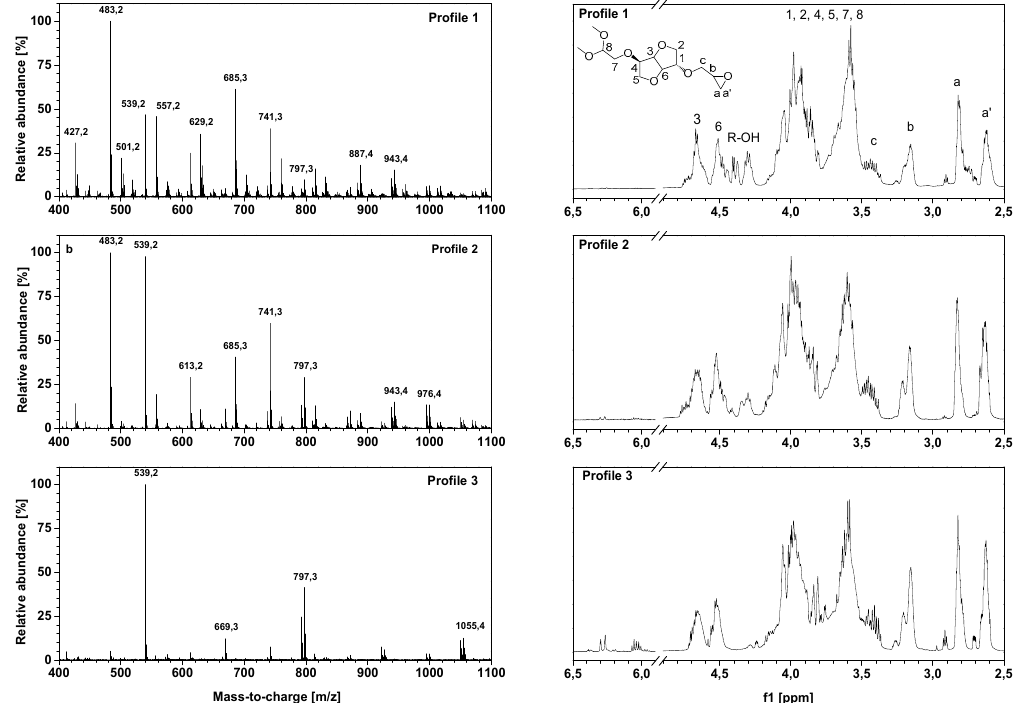
Figure3. HRMSQ-TOFspectra(left)and 1 H-NMR(400MHz,CDCl 3 ,20 ◦ C)spectra(right)ofoligo-isosorbide Figure 3. HRMS Q-TOF spectra (left) and 1 H-NMR (400 MHz, CDCl 3 , 20 °C) spectra (right) of oligo- glycidyl ethers for Profiles 1-3 obtained under ultrasonic isosorbide glycidyl ethers for Profiles 1-3 obtained under ultrasonic activation.